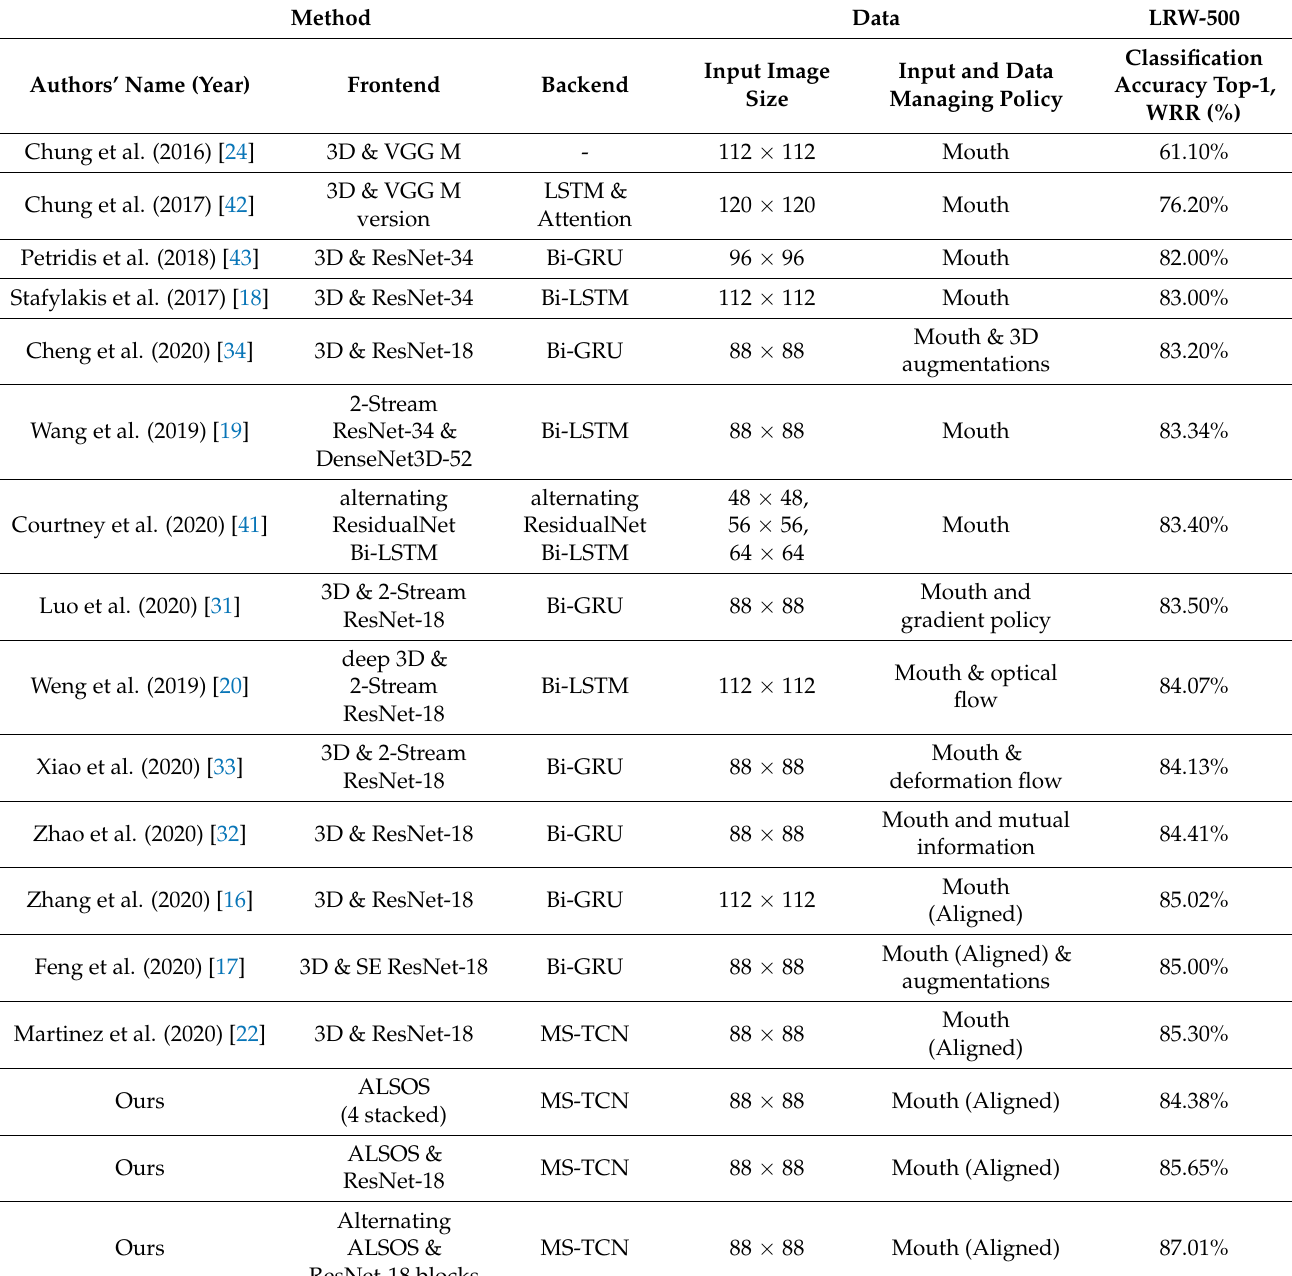
Table 4. Summary of the state-of-the-art results on the LRW-500